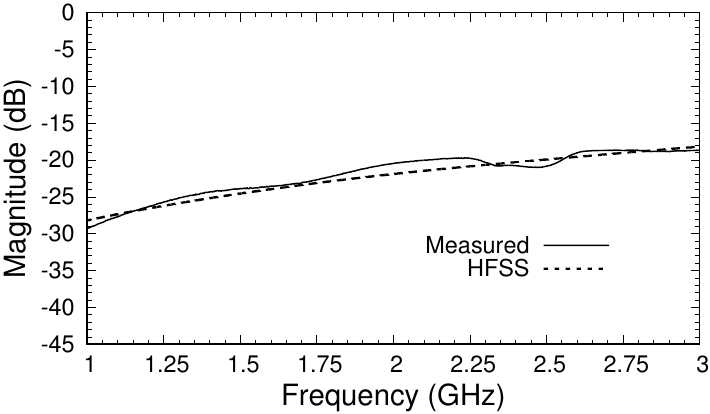
Figure 9. Magnitude of measured S 21 after calibration for the triaxial system in air.